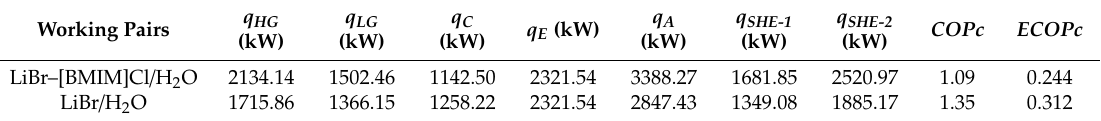
Table 5. The specific heat load at di ff erent parts of double-e ff ect absorption heat pump